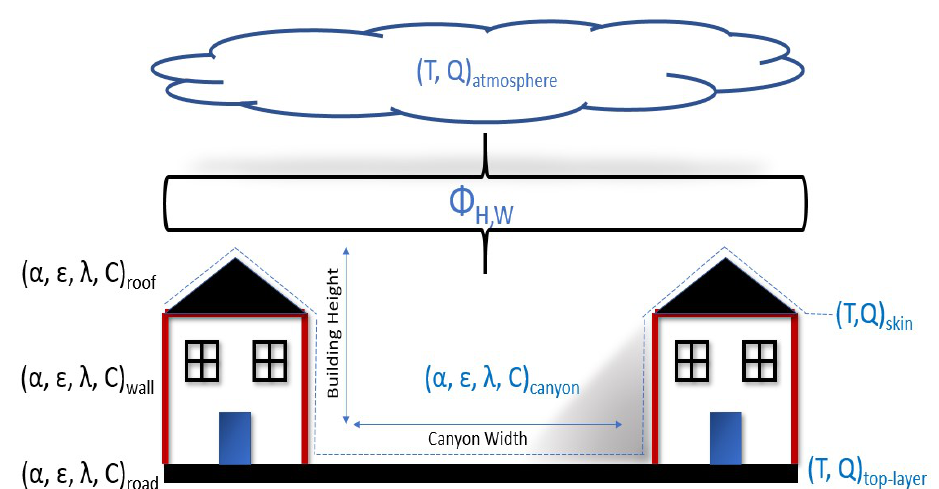
Figure 8. Schematic of the single-layer urban model used in ECLand including key parameters ( α : albedo, ε : emissivity, λ : thermal conductivity, C : volumetric heat capacity), variables ( T : temperature, Q : moisture content), and fluxes of heat and moisture ( Φ H,W